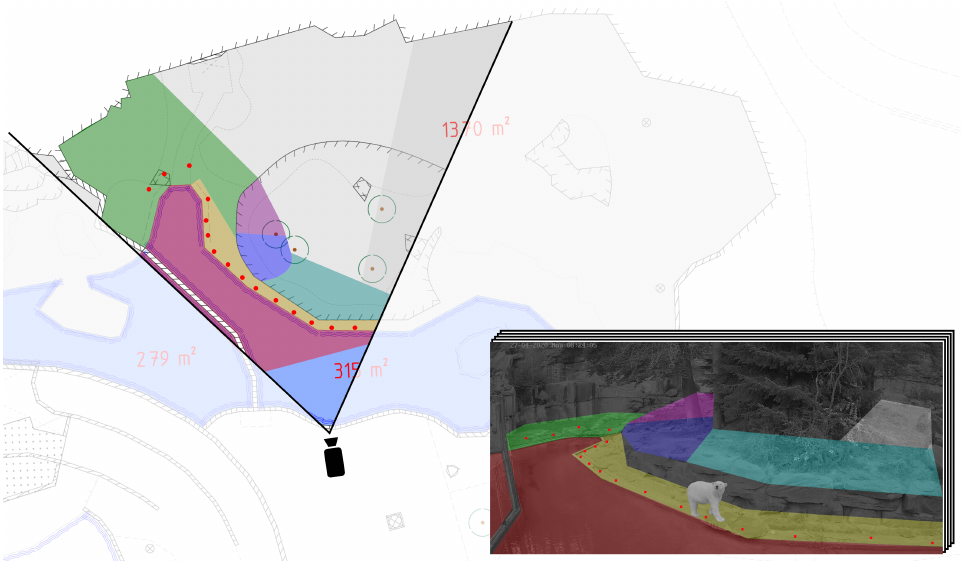
Figure 4. Schematic representation of the implemented coordinate transformation. The enclosure is divided into segments, which represent flat surfaces in good approximation. For each segment a homography matrix is determined, which then transforms the coordinates to the map of the